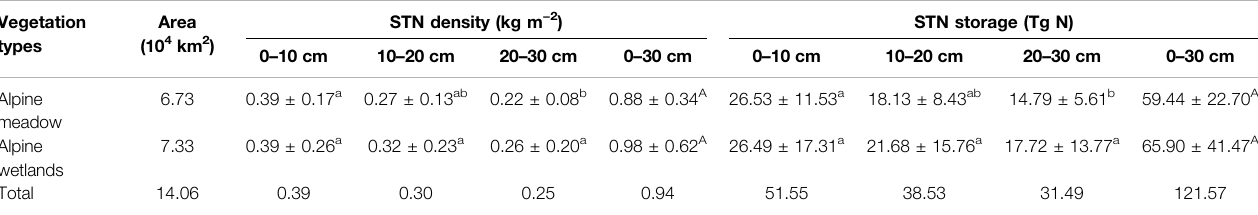
TABLE 1 | Soil total nitrogen (STN) density and storage in alpine meadow and alpine wetlands in the Three Rivers Source Region. Different lowercase letters indicate a signi fi cant difference in STN density and STN storage among soil layers in each vegetation type, while different capital letters indicate a signi fi cant difference in STN density and STN storage to 0 – 30 cm soil depth between two vegetation types.